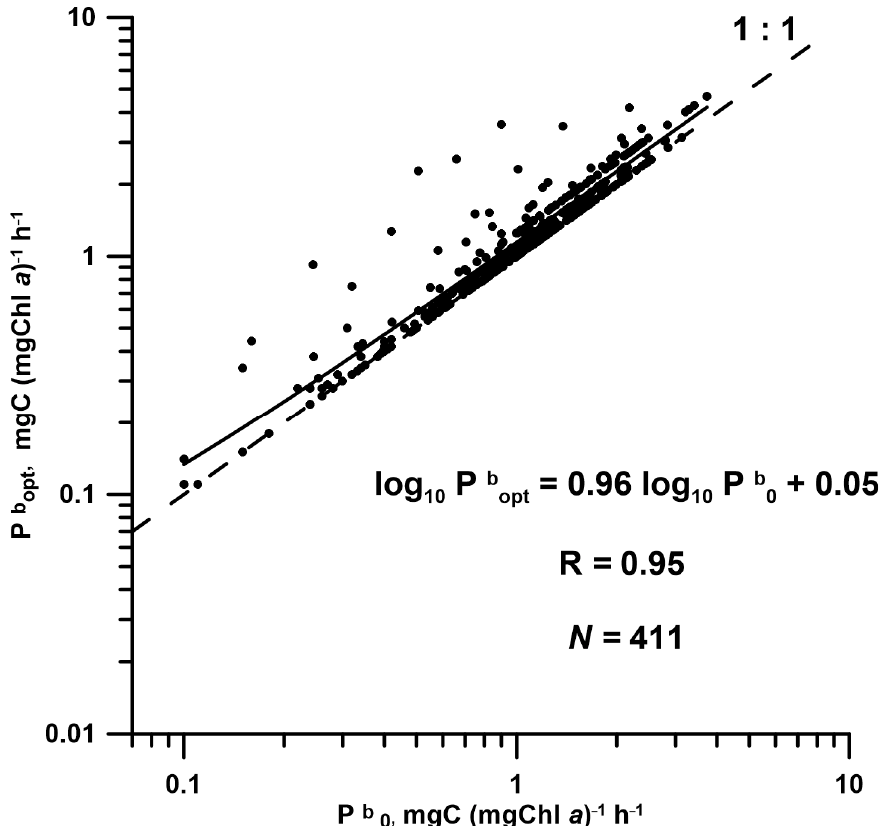
Figure 8. The relationship between the optimal assimilation number (P bopt ) and surface assimilation number (P b0 ) (black points) in the Siberian Seas. The solid line shows the line of regression. The dashed line indicates 1:1 correlation.